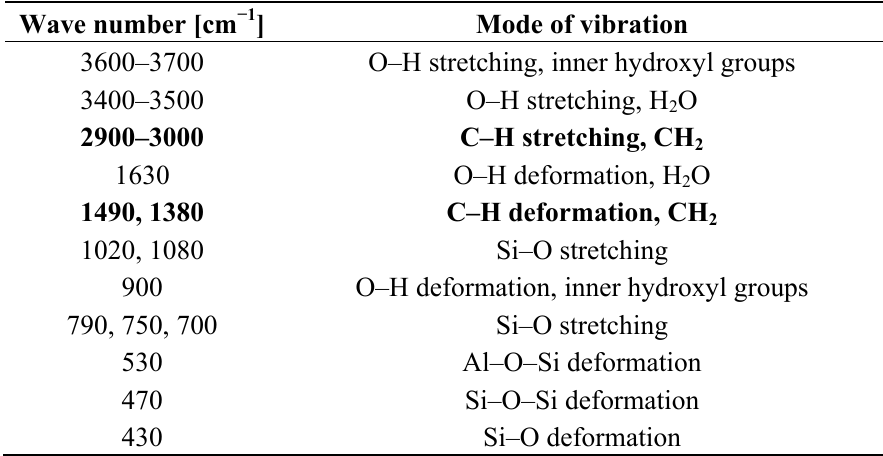
Table 2. Band assignments for the Fourier transform infrared (FTIR) spectra shown in Figure 1 [31]. Bold: Bands originating from